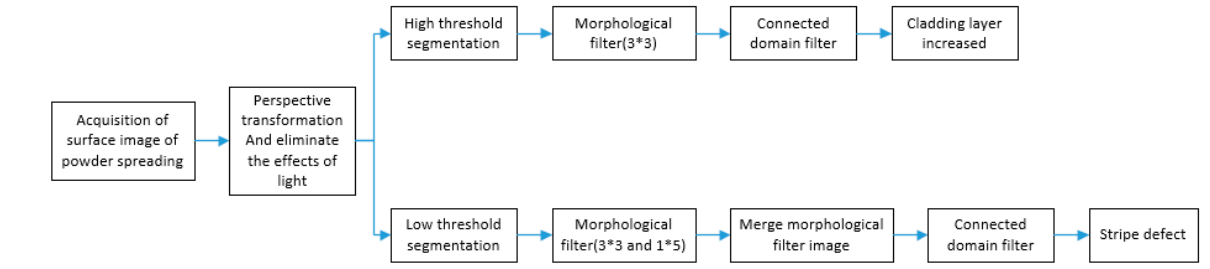
Figure 5. The flow chart of powder defect extraction.